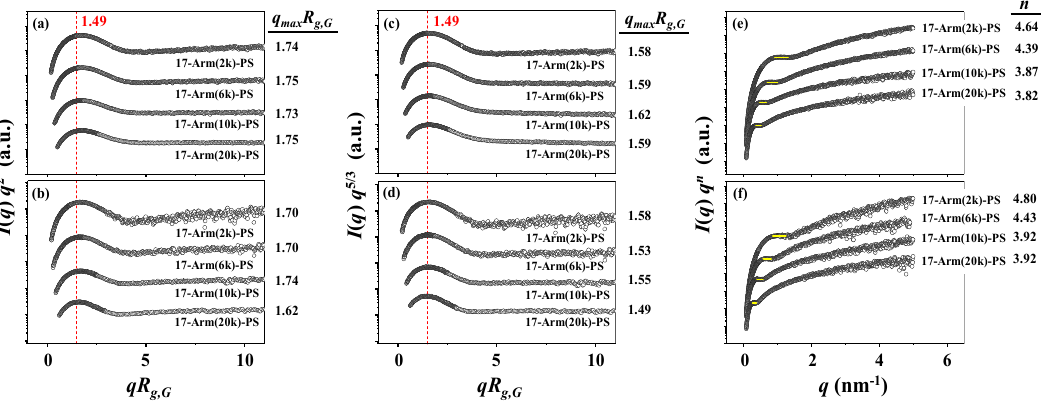
Figure 4. Kratky analysis results of the X-ray scattering data in Figure 2: ( a , c , e ) measured in CHX at 35.0 ° C ( Θ condition); ( b , d , f ) measured in THF at 25.0 ° C (good solvent).